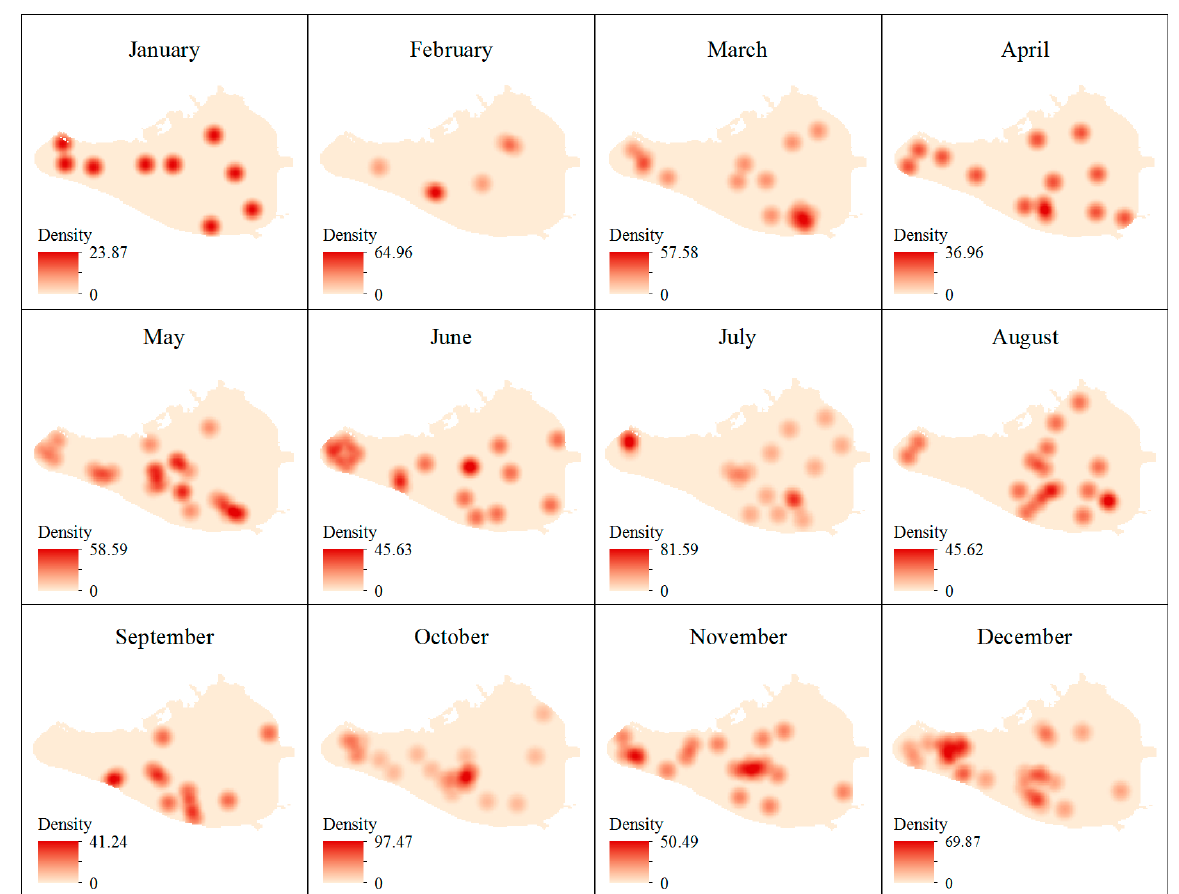
Figure 4. Monthly kernel density estimation for the burglary in the DP peninsula in 2010 (Unit: Incidents per km 2 ).